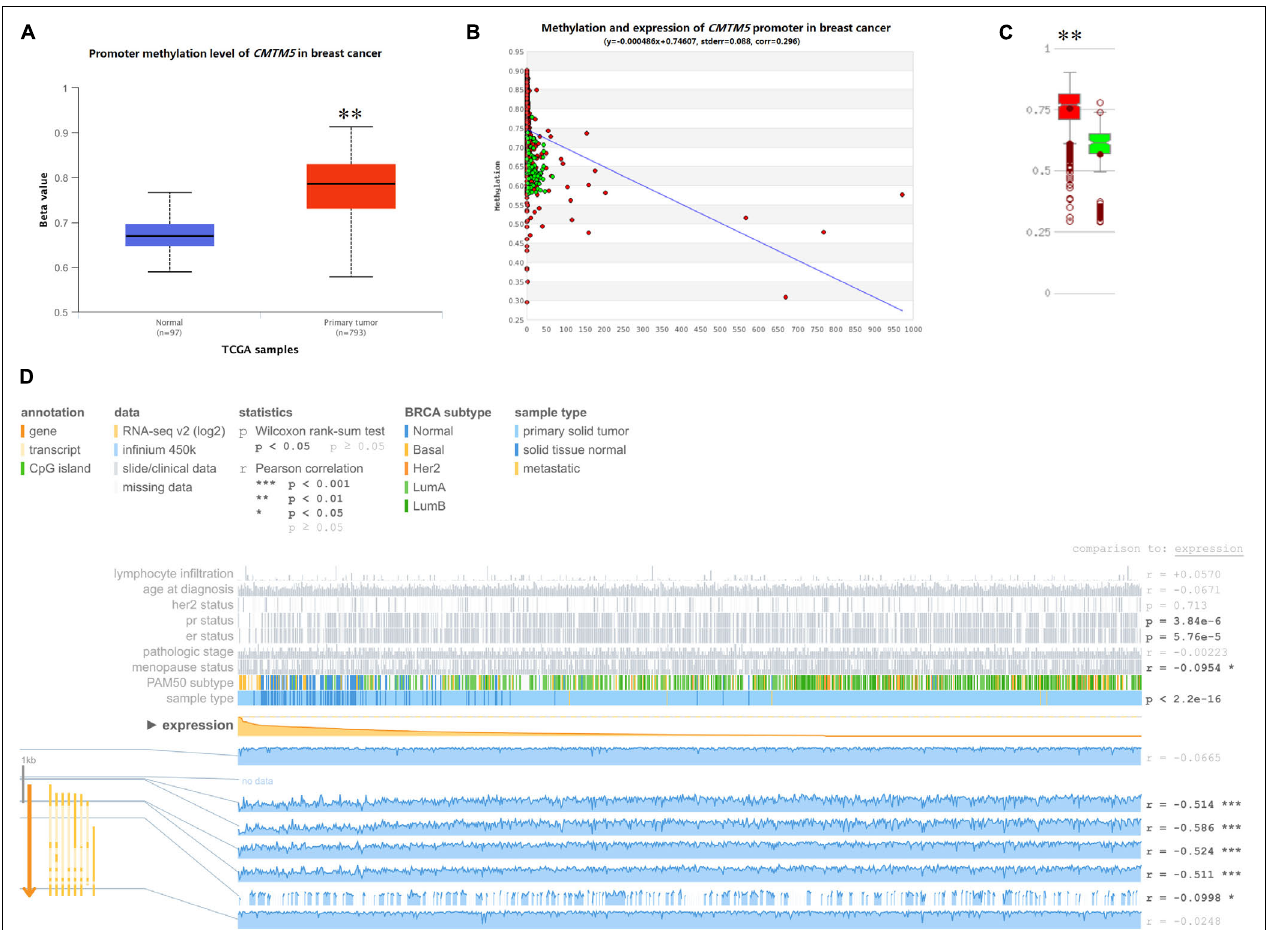
FIGURE 9 | Impact of epigenetic alterations on CMTM5 mRNA expression levels in breast cancer ( ∗∗ P < 0.01). (A) Promoter methylation levels of CMTM5 as per the analyses involving UALCAN. (B,C) Promoter methylation levels of CMTM5 as per the analyses involving MethHC. (D) CMTM5 expression levels in breast cancer related to DNA promoter methylation as per the analyses involving